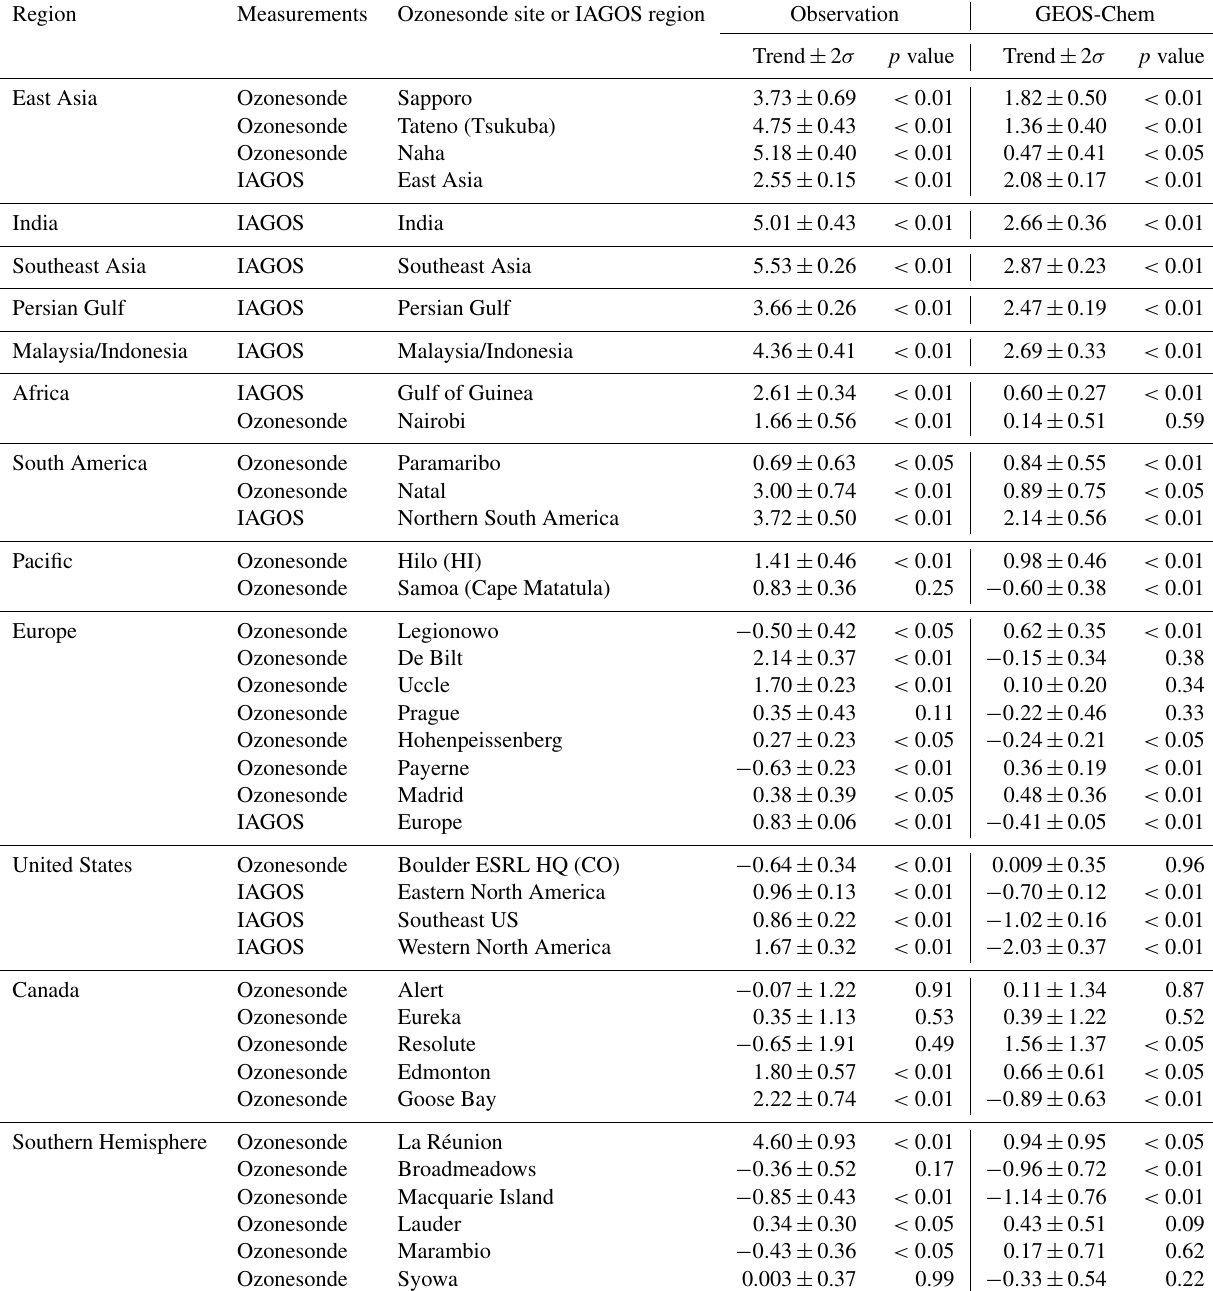
Table 4. Annual trends and 2 σ uncertainty (ppbv per decade) in median ozone for the tropospheric column (950–250hPa) in 1995–2017 from both observations and